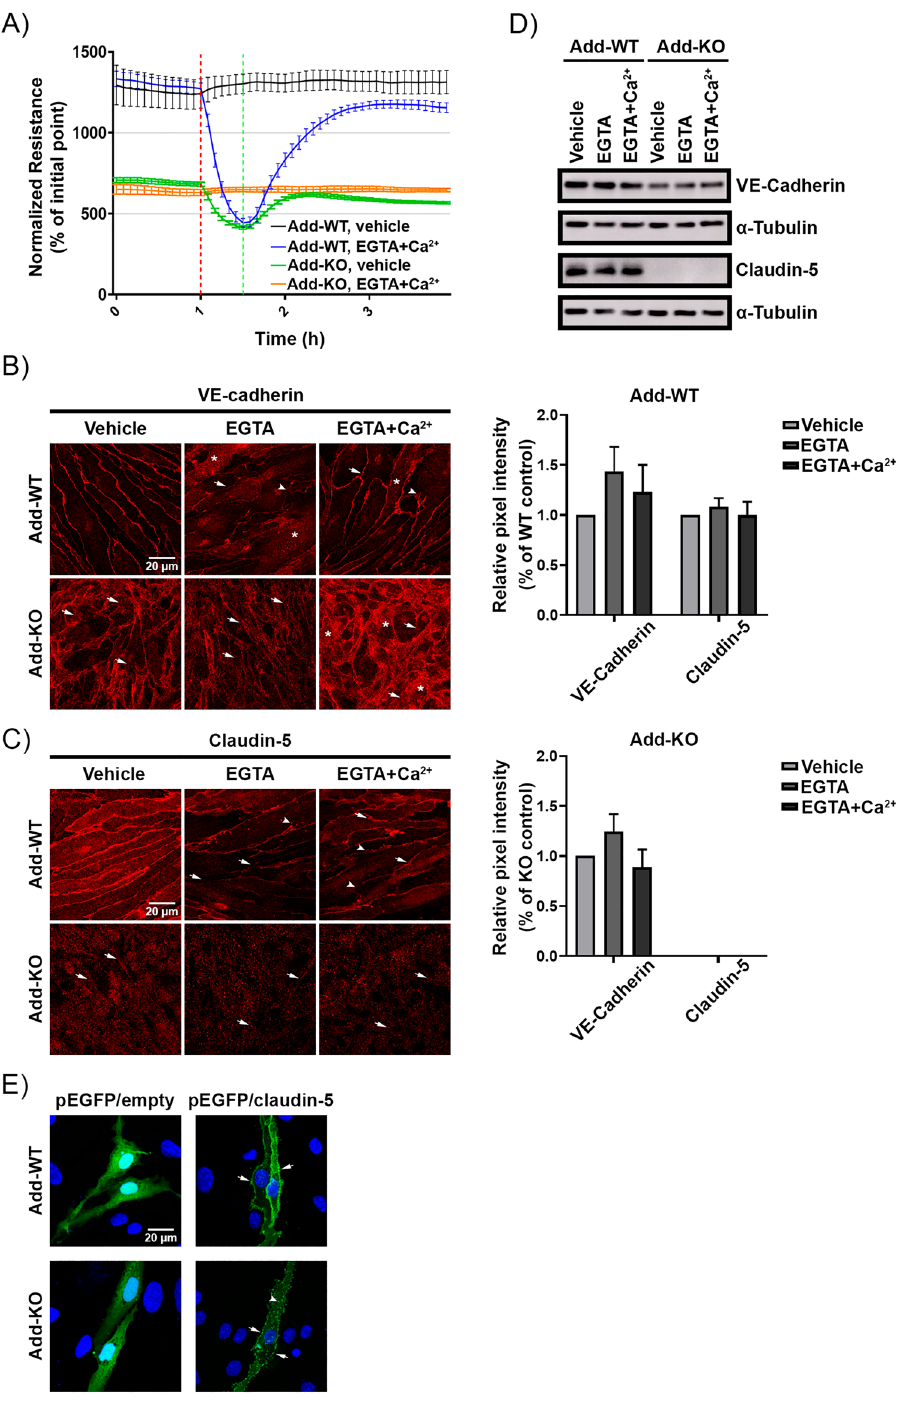
Figure 4. Role of Adducin in Ca 2+ -mediated recovery of endothelial barrier integrity. ( A ) Time course of TER changes in cell monolayers derived from WT and Add-KO cells subjected to Ca 2+ switch. Addition of EGTA initiate disorganization of Ca 2+ -dependent junctions (red-dotted line). Reconstitution of Ca 2+ engages recovery of Ca 2+ -dependent junctions (green-dotted line) (N = 4). ( B ) Immunostaining for VE-cadherin and C) claudin-5 of WT and Add-KO cell monolayers subjected to Ca 2+ switch (N = 4). ( D ) Western blot analysis of VE-cadherin and claudin-5 protein expression after Ca 2+ switch (N = 6). The bar diagrams represent the densitometric analysis of the respective blots. E) Representative confocal images of WT and Add-KO cells transiently transfected with either empty or pEGFP-claudin-5 vectors. The nuclei were stained using DAPI (N =